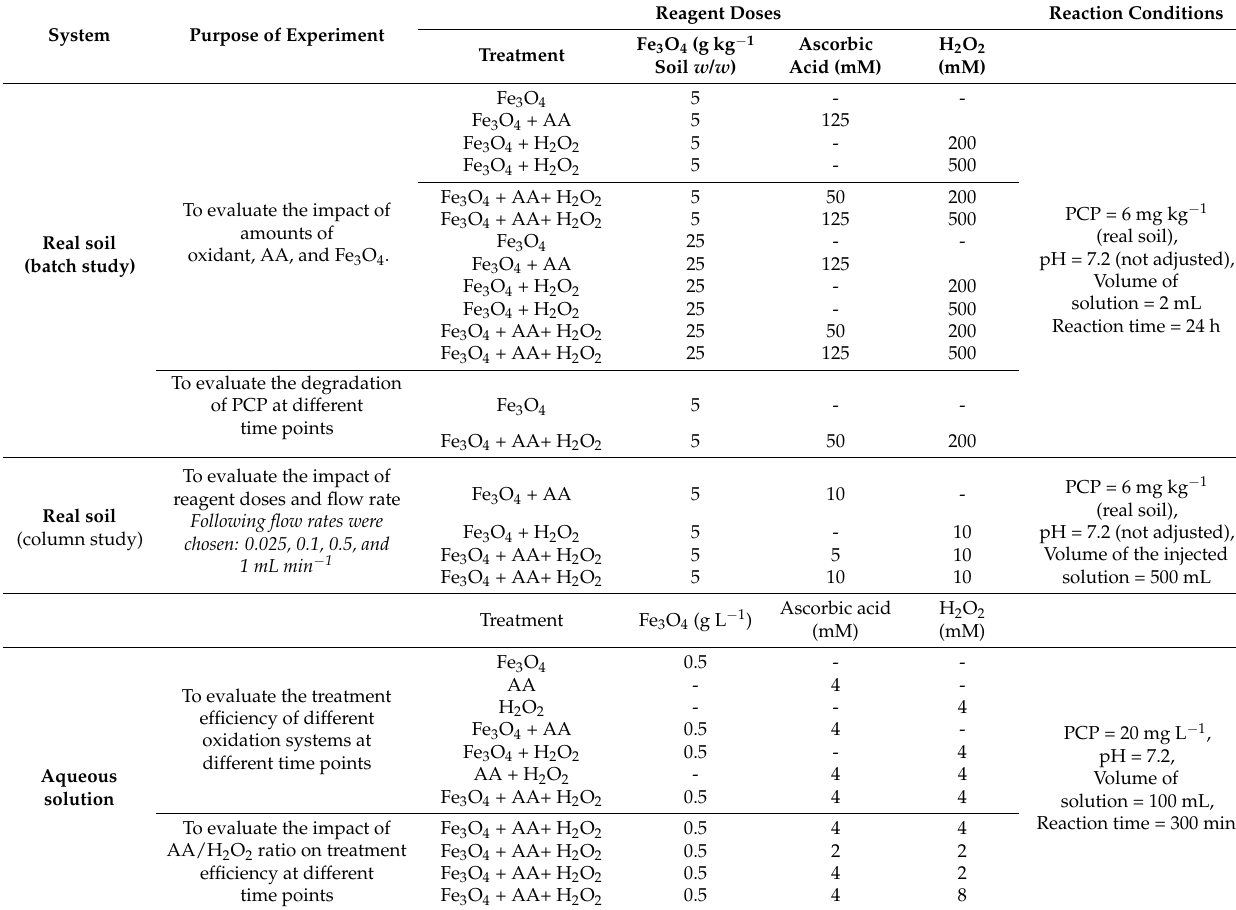
Table 1. A summary of the experiments performed in real contaminated soil (batch and column) and aqueous solution.